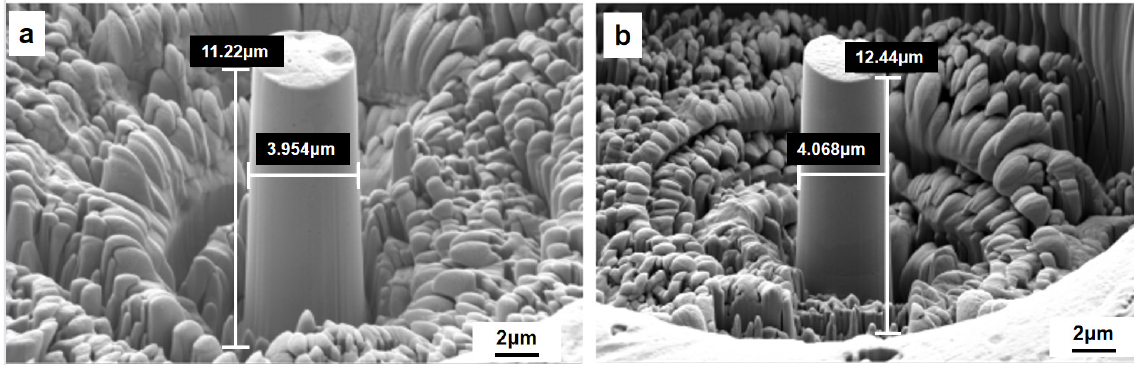
Figure 9. SEM image of FIB cone structure of SLM HEA: ( a ) FIB sampling section is perpendicular to the BD and ( b ) FIB sampling section is parallel to the BD.